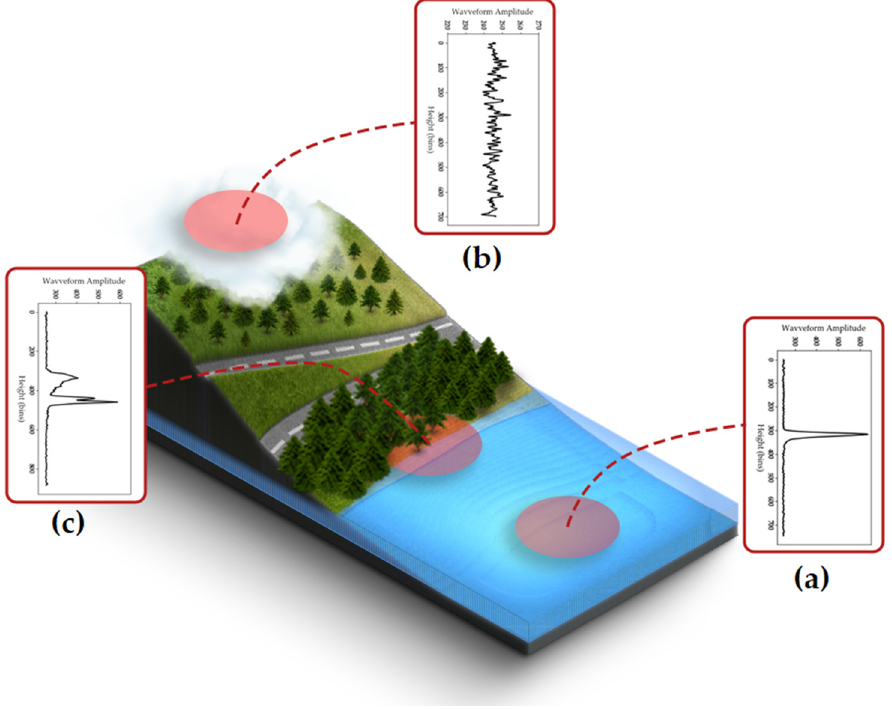
Figure 2. Example of three acquired GEDI waveforms: ( a ) over water surface, ( b ) in the presence of clouds, and ( c ) at the limit between water and the shoreline.